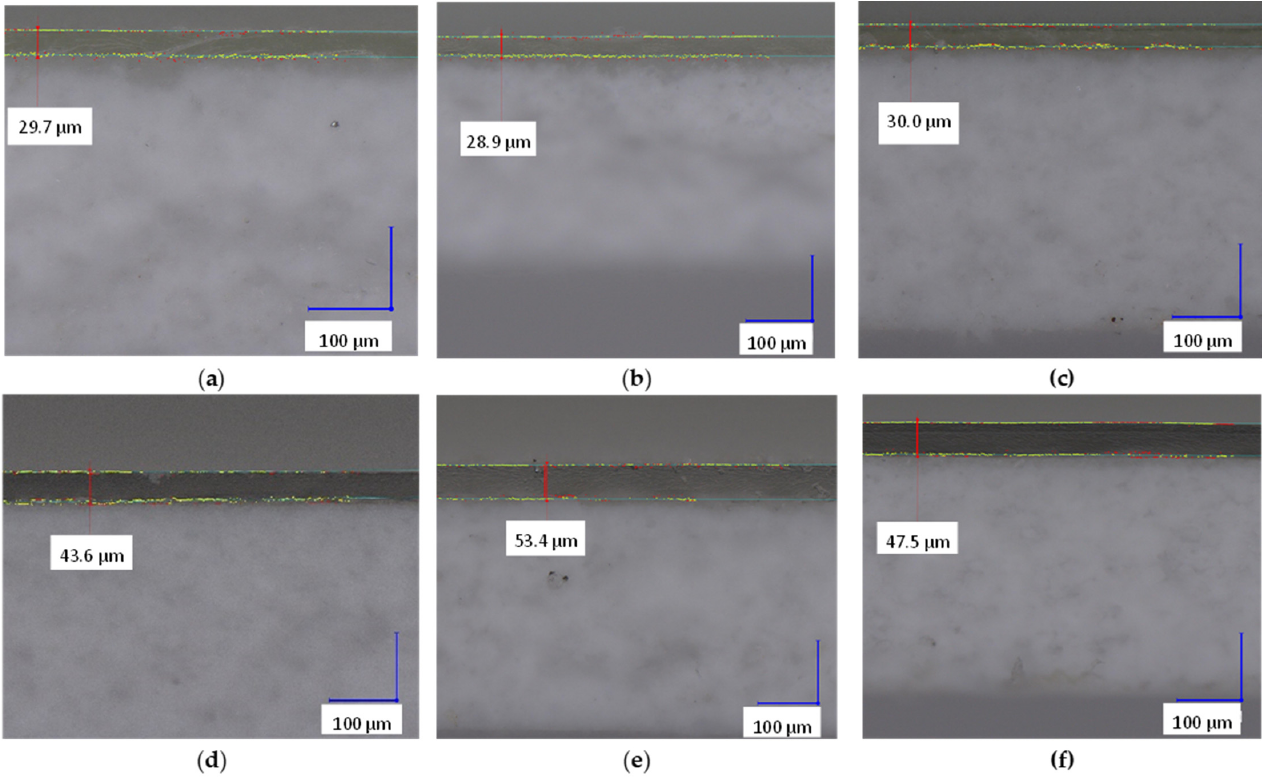
Figure 2. Representative cross-section micrographs for ( a ) UL5, ( b ) UL6, ( c ) UL7, ( d ) EbS-1, ( e ) EbS-2, and ( f ) EbS-3. The images show a clear interface between the substrate and the coating layer.